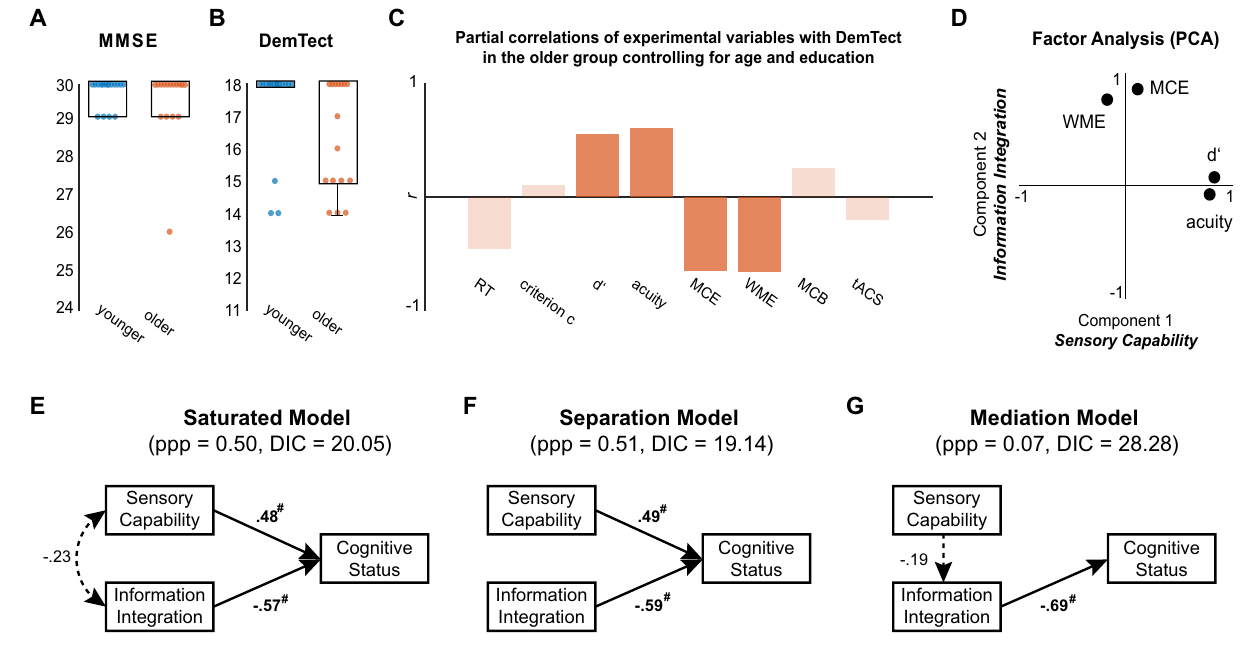
Figure 6. Bayesian structural equation modelling (BSEM) of cognitive status. ( A ) Distributions of Mini- Mental State Examination (MMSE) scores for younger and older participants. ( B ) Distributions of DemTect scores for younger and older participants. ( C ) Partial correlations between cognitive status (DemTect) and grand average response time (RT), grand average criterion c, grand average d ′ , average sensory acuity (acuity, see “Methods” for details), multisensory congruence enhancement (MCE, see “Methods” for details), working memory enhancement (WME, see “Methods” for details), multisensory congruence bias (MCB, see “Methods” for details) and the average tACS effect (tACS, see “Methods” for details). Correlations are controlled for the influence of age and education. Shading indicates non-significant correlations at p > 0.05. ( D ) Principal component analysis (PCA) separated the four variables into two distinct components termed “Sensory capability” and “Information integration”. ( E ) Path diagram of the saturated model. ( F ) Path diagram of the separation model. ( G ) Path diagram of the mediation model. Dotted lines show non-significant paths (# signifies that the Bayesian estimate’s credibility interval did not include 0). Standardized estimates are shown. ppp posterior predictive p value. DIC deviance information criterion.